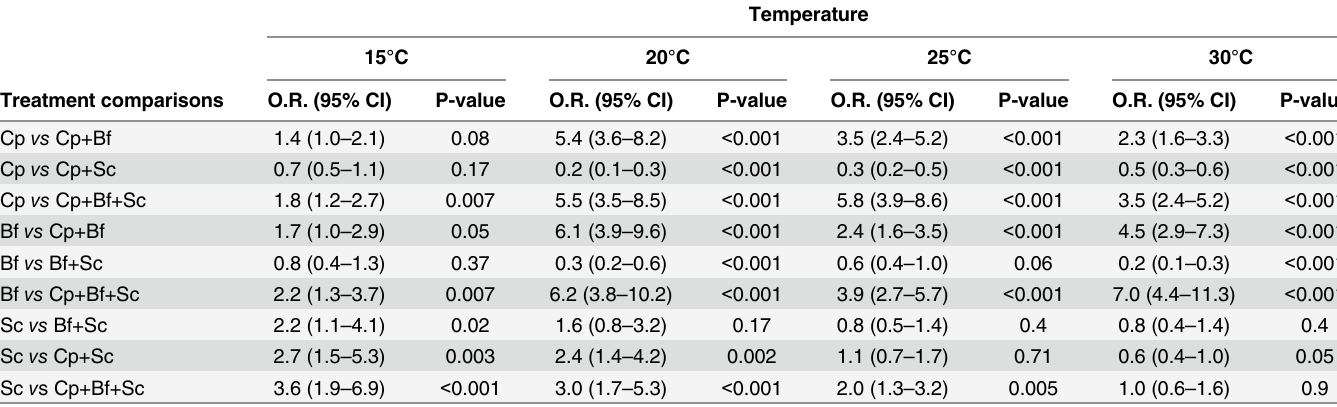
Table 5. Results of GLM analysis comparing survival between single-species and multi-species communities under different constant temperatures.